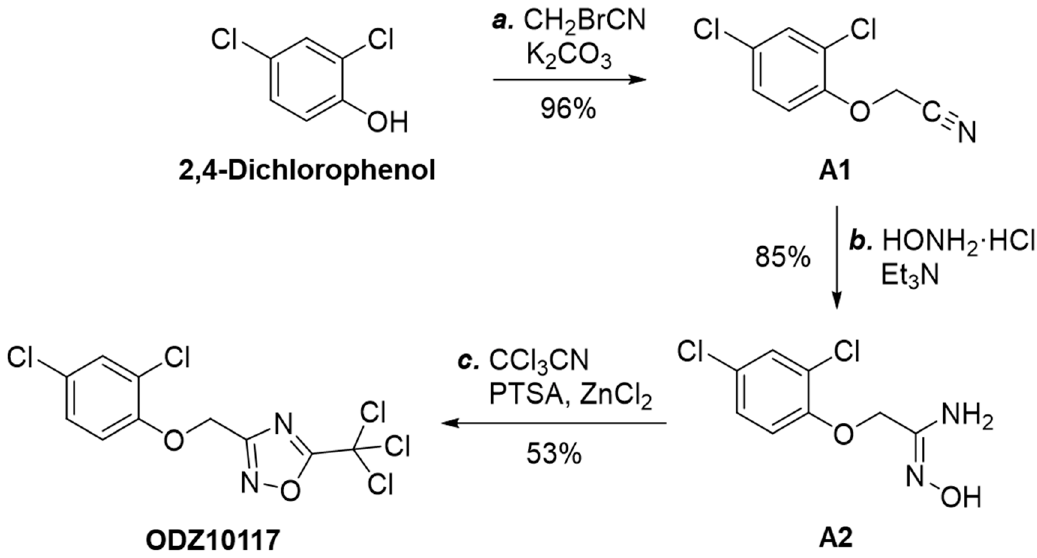
Figure 3. Synthetic scheme of ODZ10117. Reagents and conditions: ( a ) bromoacetonitrile (1.0